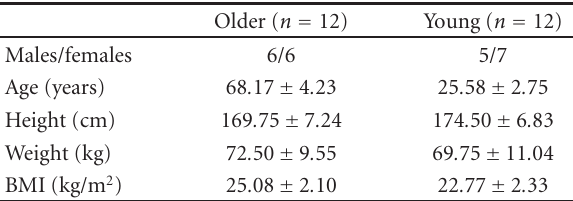
Table 1: Subjects’ gender anthropometric characteristics (means ± standard